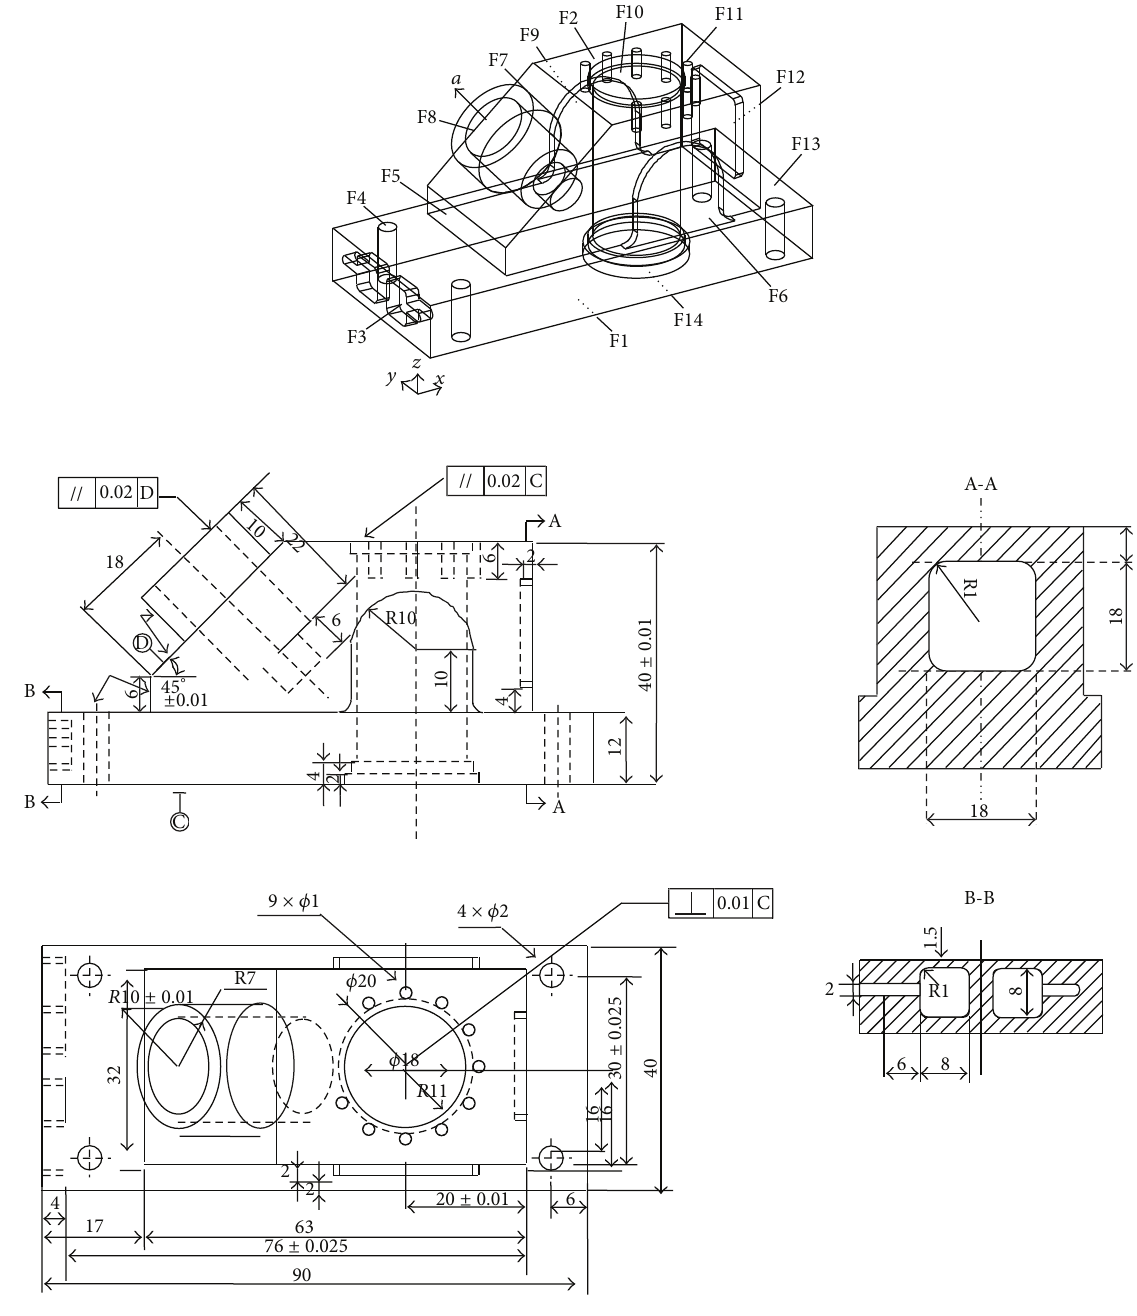
Figure 4: A sample